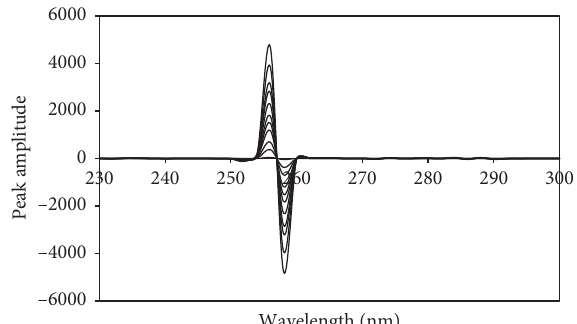
Figure 9: Successive derivative ratio spectra of 1, 3, 5, 8, 10, 12, 15,